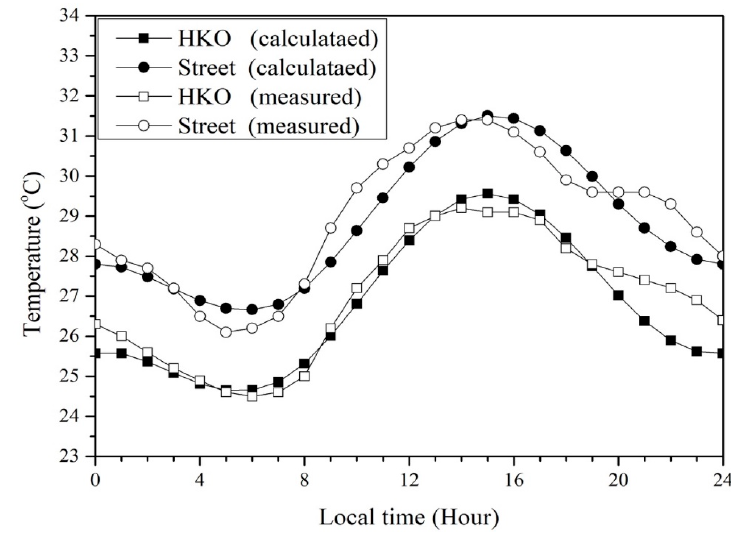
Figure 13. The measured and simulated air temperature in the HKO station and in the street.